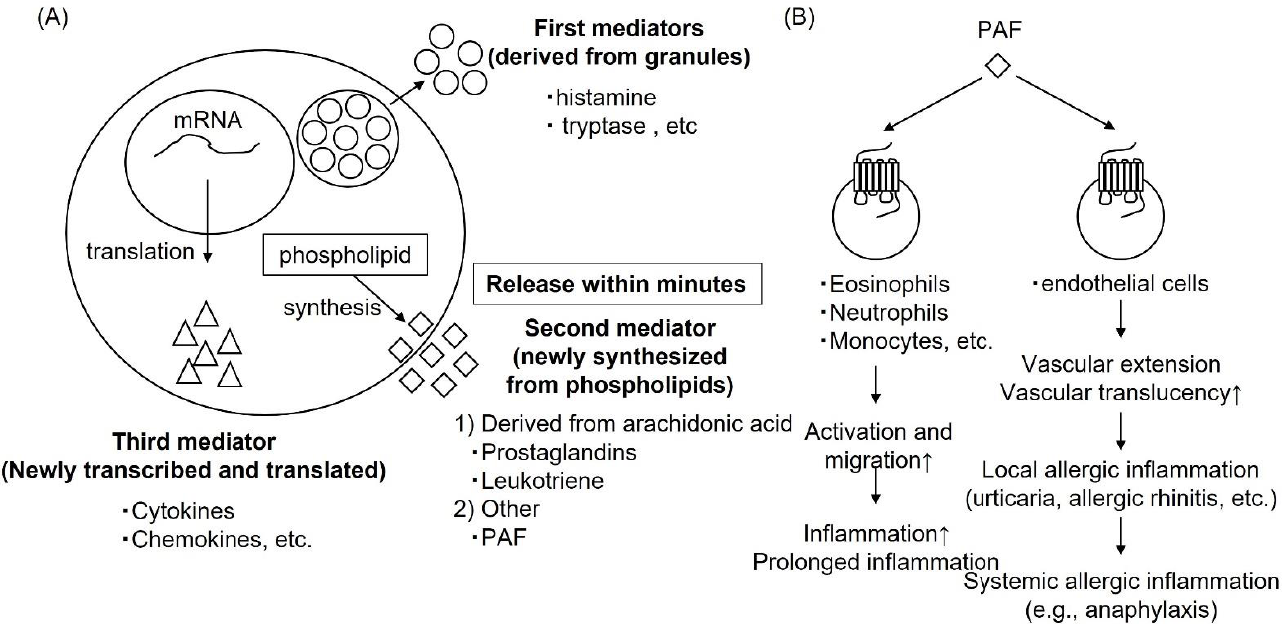
Figure 5. Mechanisms by which mediators released from mast cells ( A ) and PAF induce allergic inflammation ( B ). ( A ) Circles mean first mediators derived from granules, such as histamine or tryptase. Squares mean second mediators newly synthesized from phospholipids, such as prostaglandins, leukotrienes, which derived from arachidonic acid, or PAFs. Triangles mean third mediators newly transcribed and translated, such as cytokines or chemokines.